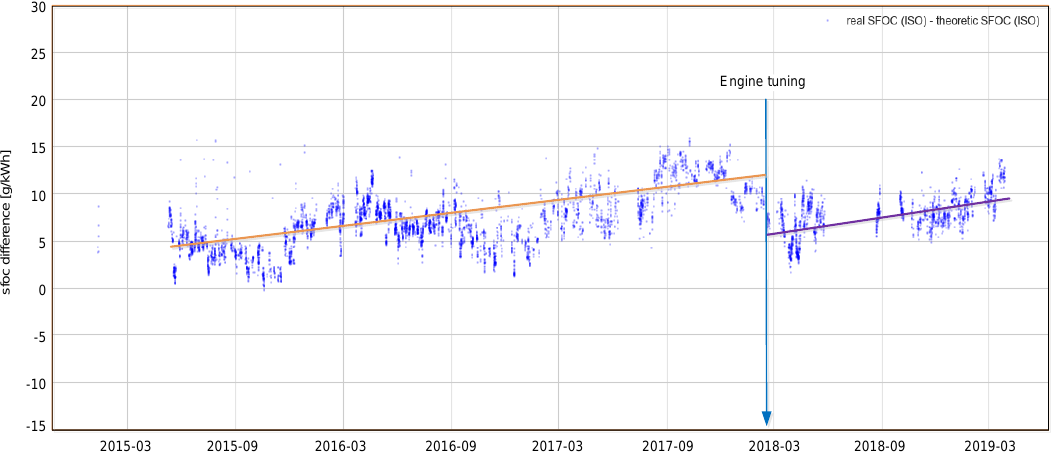
Figure 3. Main engine specific fuel oil consumption (SFOC) trend with visible gradual deterioration of engine performance [14]. (Courtesy of Enamor